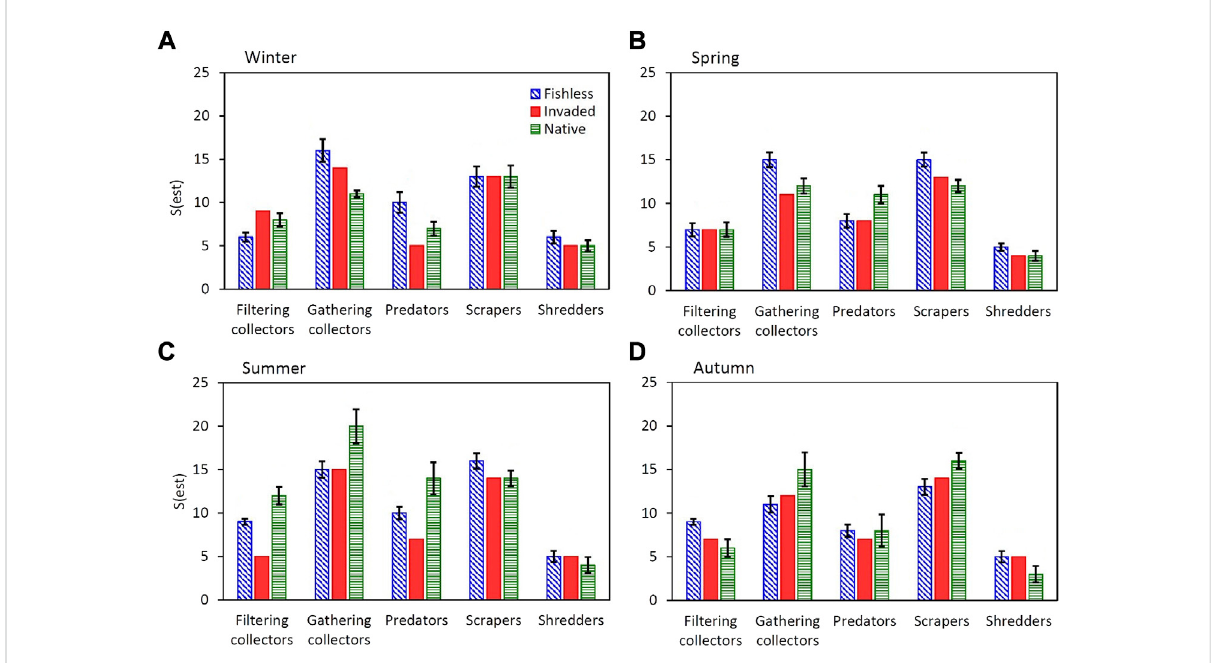
FIGURE 6 Species richness from accumulation curves at 20 samples for (A) . Winter, (B) . Spring, (C) . Summer and (D) . Autumn, for separate functional groups per fi shless, invaded and native fi sh river reaches. Error bars indicate standard deviations of S(est). See Supplementary Table S2 for further